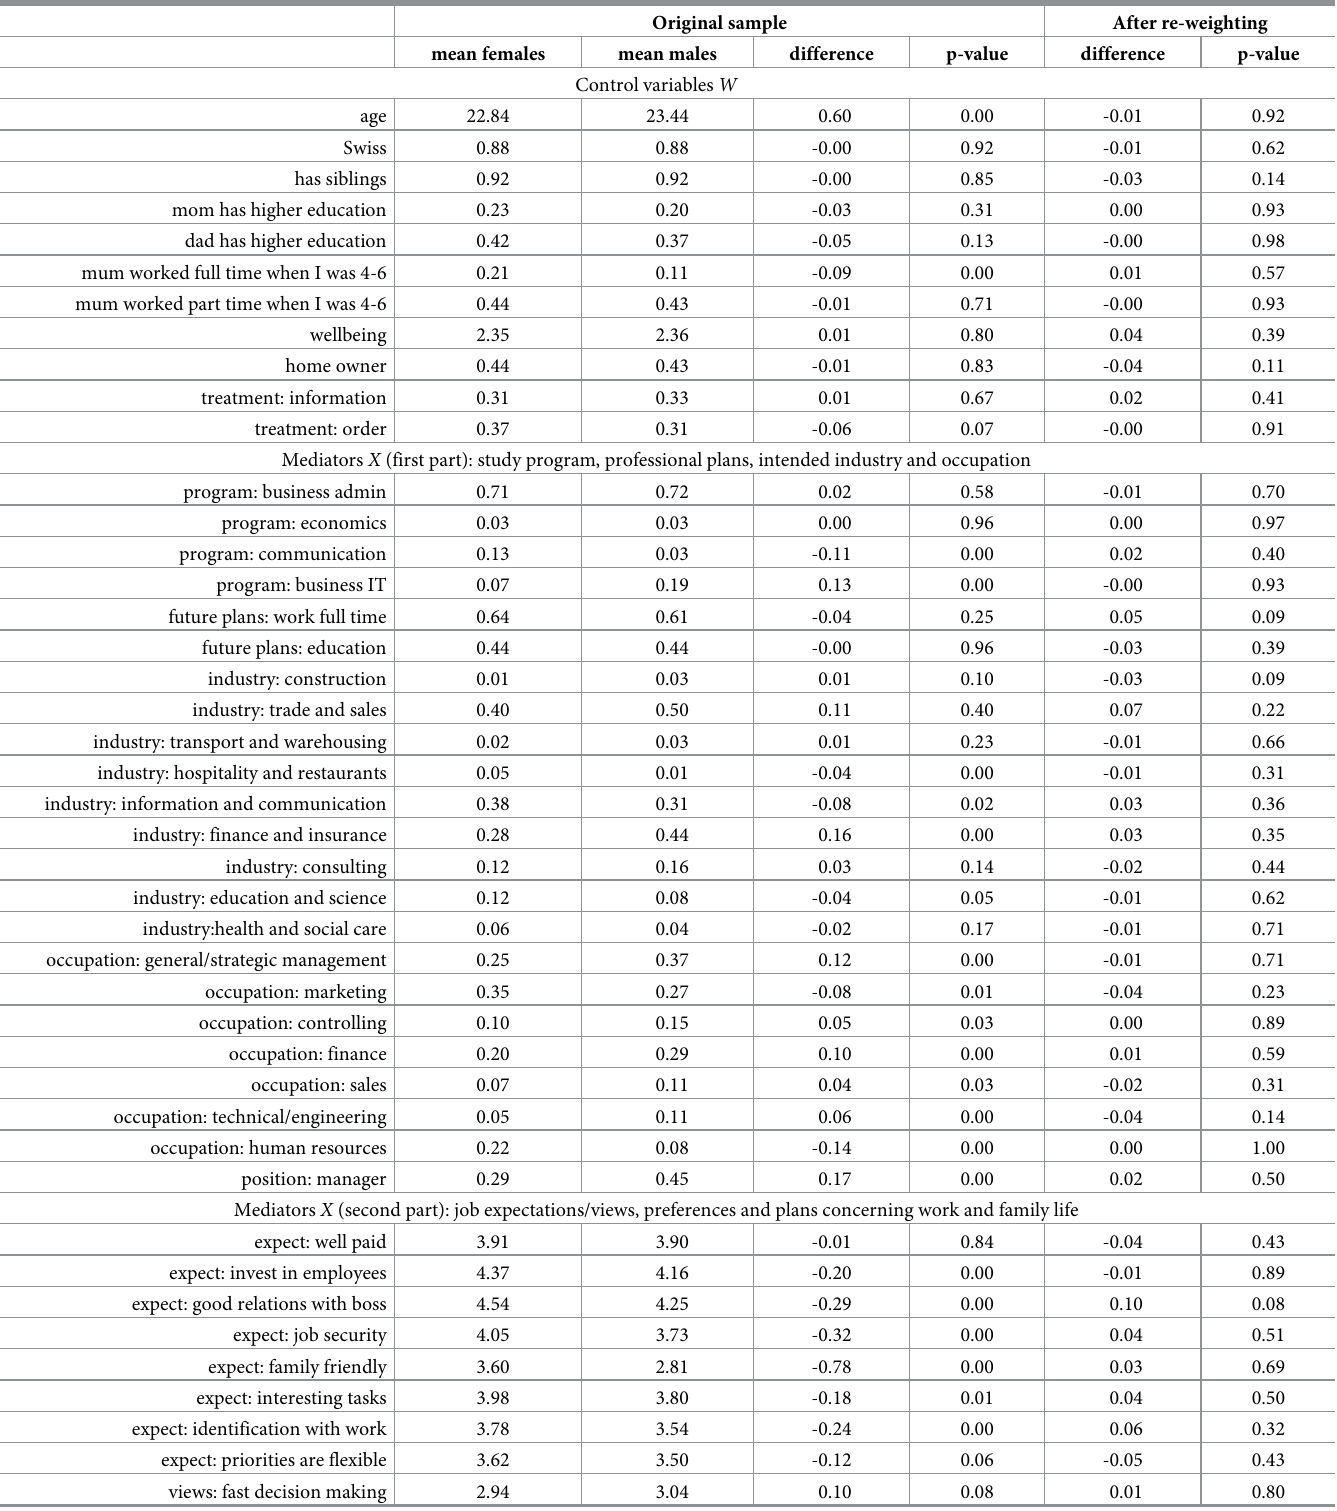
Table 5. Descriptives and balance tests for covariates and mediators.